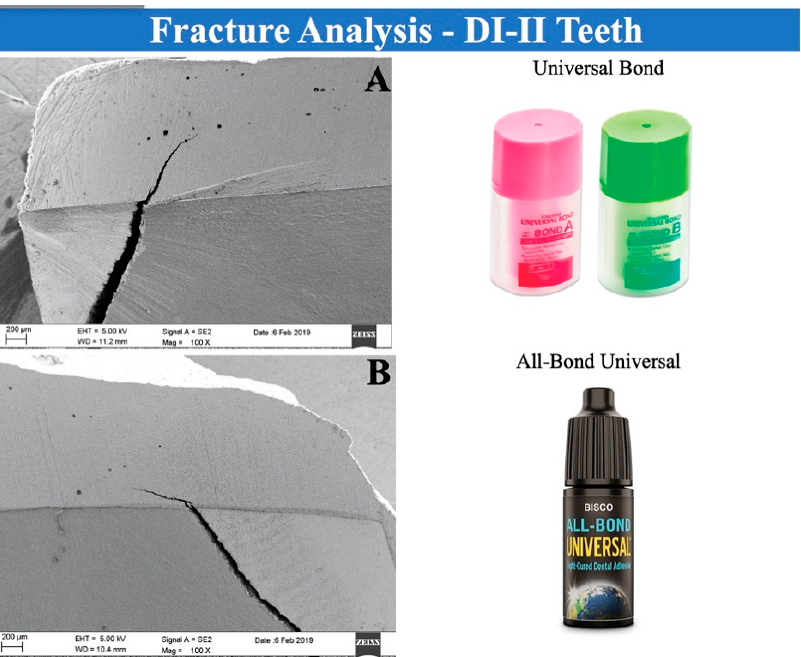
Figure 4. SEM images of fractures in samples with Universal Bond ( A ) and All-Bond Universal ( B ) on a tooth affected by DI-II. The fractures depicted occurred during sample processing for SEM due to dehydration; this occurs due to the different content of water between enamel and dentin, causing the dentin to shrink and separate from enamel. The way the fracture ends in the composite mass, tells that bonding between dentin and composite is equal or stronger than the natural bonding between enamel and